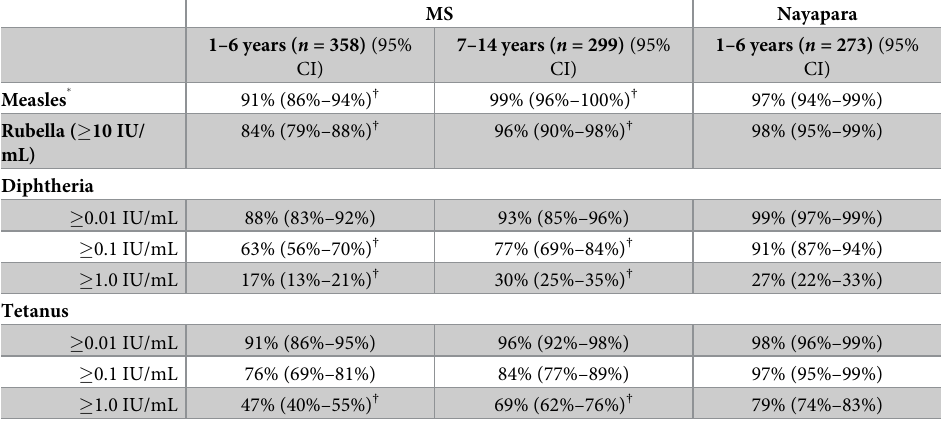
Table 4. Percentage of children seroprotected based upon predefined antibody level cutoffs for measles, rubella, tetanus, and diphtheria, by geographic area and age group, serologic and vaccination coverage survey among Rohingya children, Cox’s Bazar, Bangladesh,